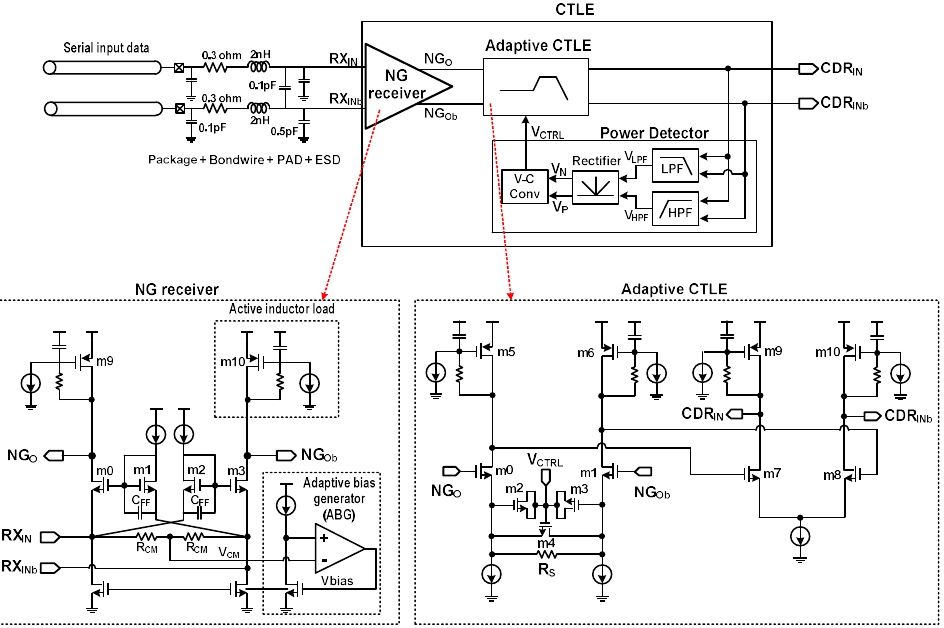
Figure 7. Block diagram of the proposed CTLE.